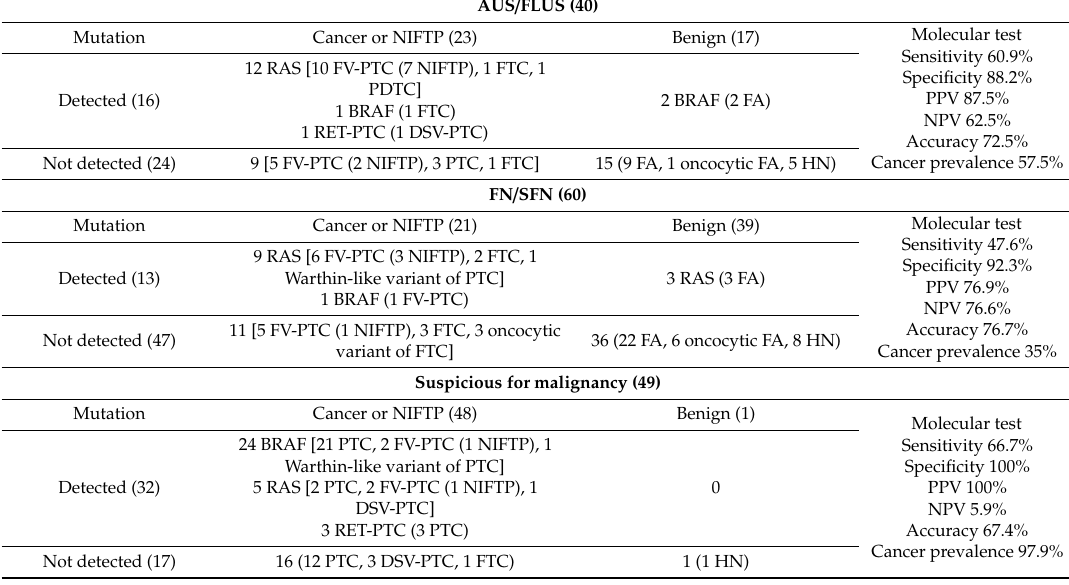
Table 3. Correlation between cytology, molecular, and pathology diagnosis in 149 indeterminate fine-needle aspiration (FNA)